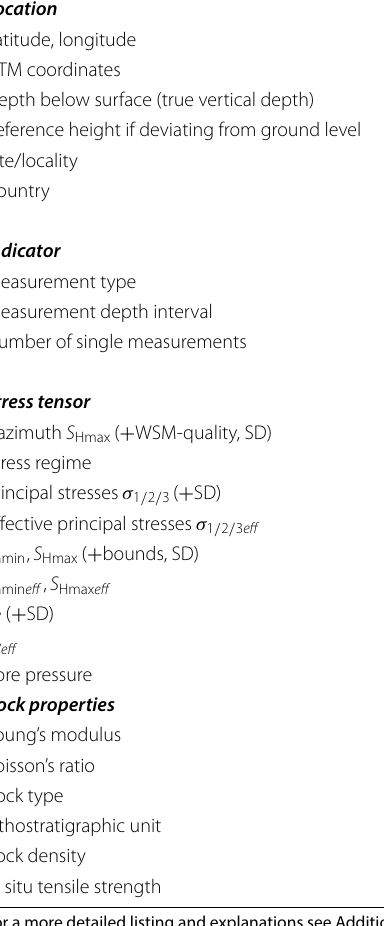
Table 1 Information included in the stress magnitude database Location Pressure measurements Latitude, longitude Breakdown pressure ( UTM coordinates Reopening pressure ( Depth below surface (true vertical